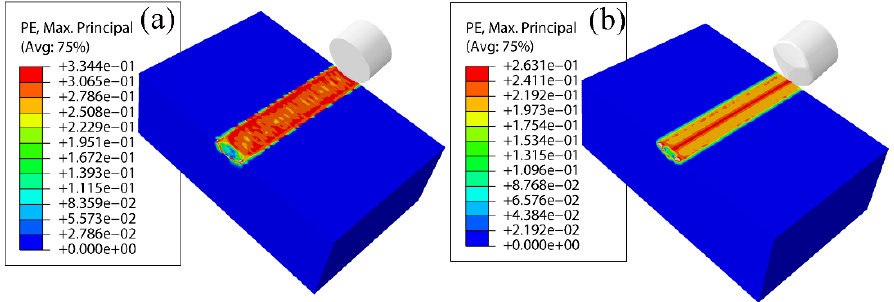
Figure 9. Plastic strain in rock-cutting process: ( a ) Conventional cutter; ( b ) 3-RDE cutter.